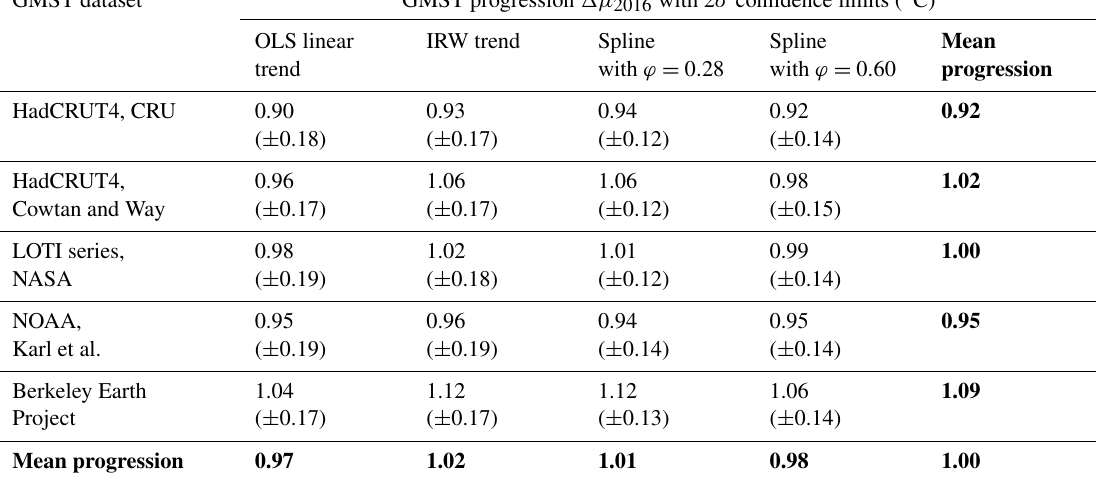
Table 2. Trend increments (cid:49)µ 2016 along with 2 σ confidence limits. Increments are given for the five GMST series given in Table 1, and the four trend approaches proposed in Sect. 2.2. Values in bold are row and column